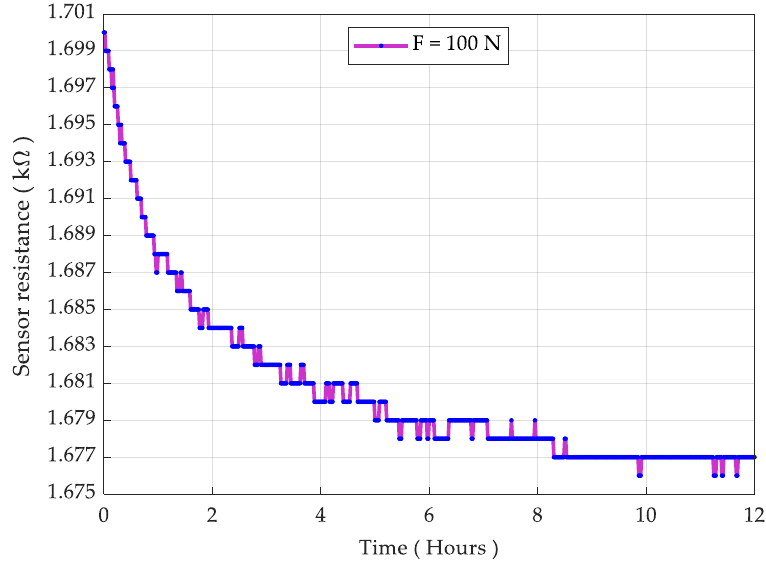
Figure 9. Sensor drift under the load of 100 N downwards force (10 kg).